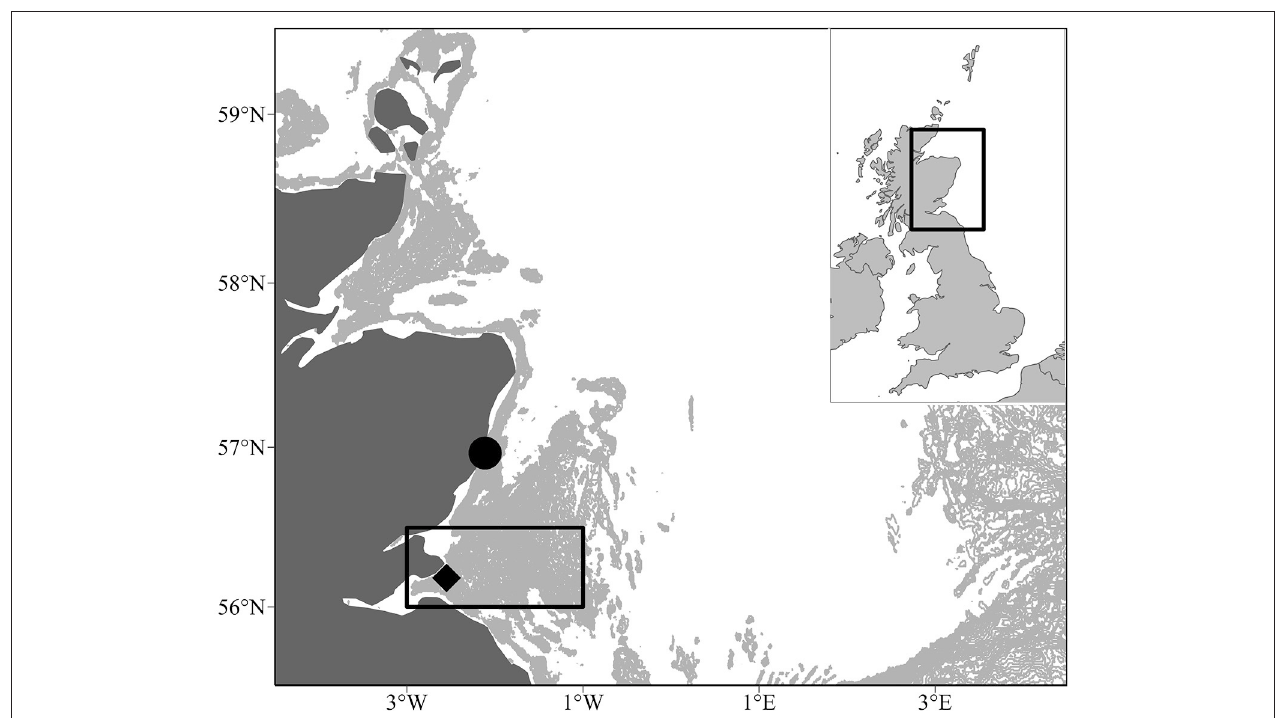
FIGURE 1 | Location of the study area off the Scottish east coast (black box, 56 ◦ 00N and 56 ◦ 30N and longitudes 003 ◦ 00W and 001 ◦ 00W). The pale gray shaded area indicates water depths between 30 and 70m. This covers the Wee Bankie/Marr Bank/Berwick’s Bank sandbank complex, which is prime sandeel habitat ( Proctor et al., 1998; Pedersen et al., 1999). The black diamond denotes the Isle of May seabird colony. The black circle denotes the plankton monitoring site at Stonehaven where food and temperature measurements were taken between 2000 and 2008 (56 ◦ 57.83’N, 002 ◦